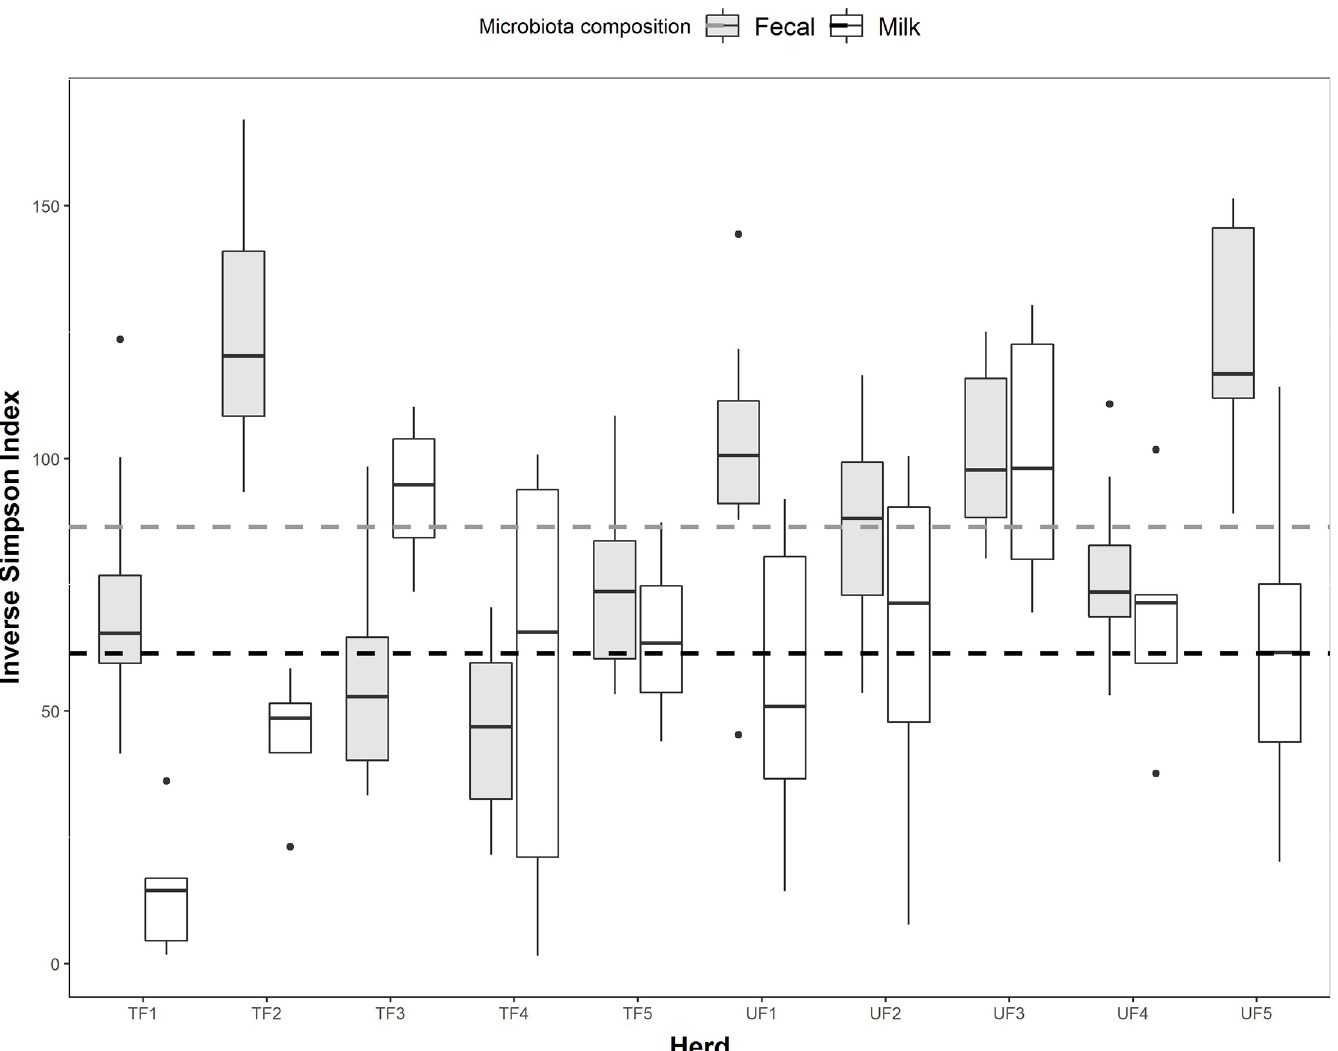
Fig 4. Estimates of microbiota richness of raw milk (white bars) and fecal samples (grey bars) of commercial Alpine dairy cows. Boxplot of observed values of the Inverse Simpson Index for milk and fecal microbiota across ten herds either fed traditionally (TF) or with unifeed (UF) in the Province of Trento, Italy. Horizontal dashed lines represent the mean values for each corresponding microbiota. Dots are observations not included between the